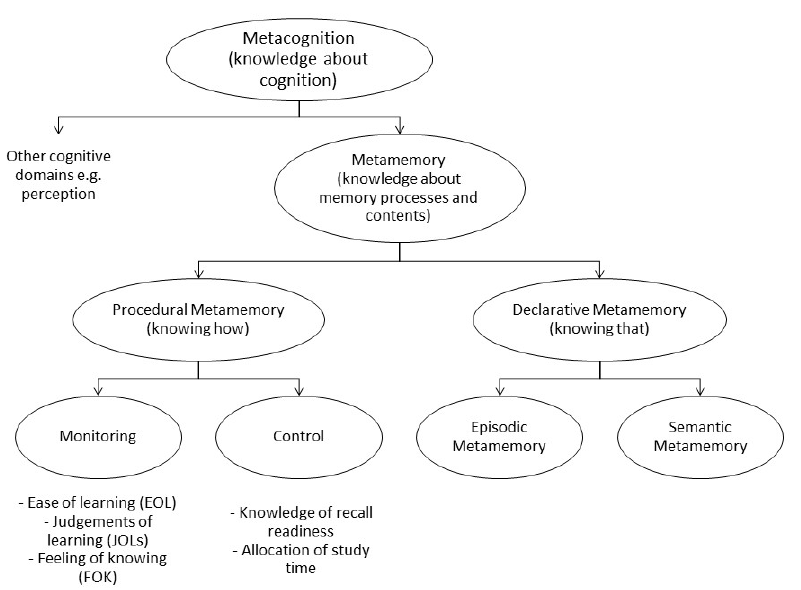
Figure 1. A possible taxonomy of metacognition.